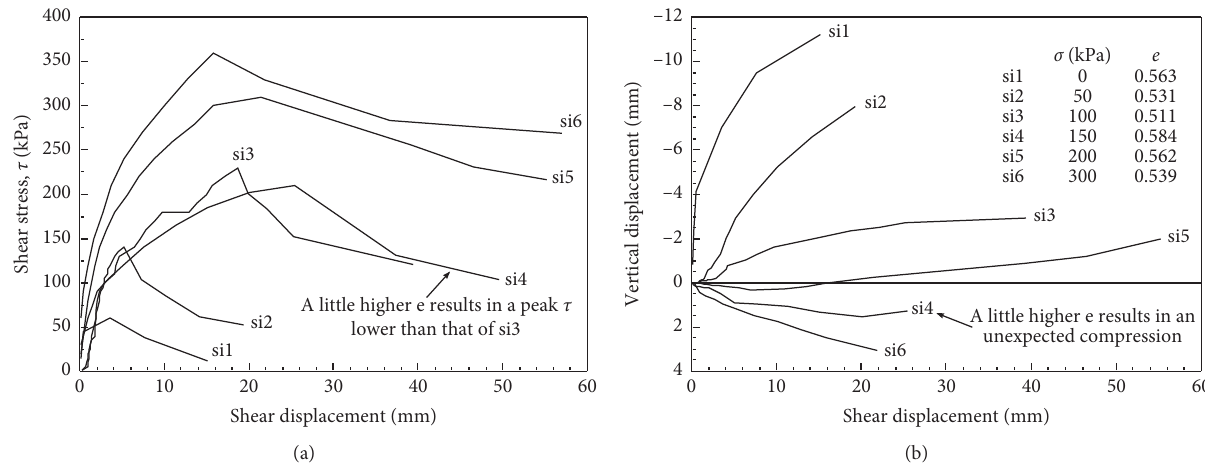
Figure 5: Data of the in situ direct shear tests under dry condition. (a) Shear stress versus shear displacement. (b) Vertical displacement versus shear